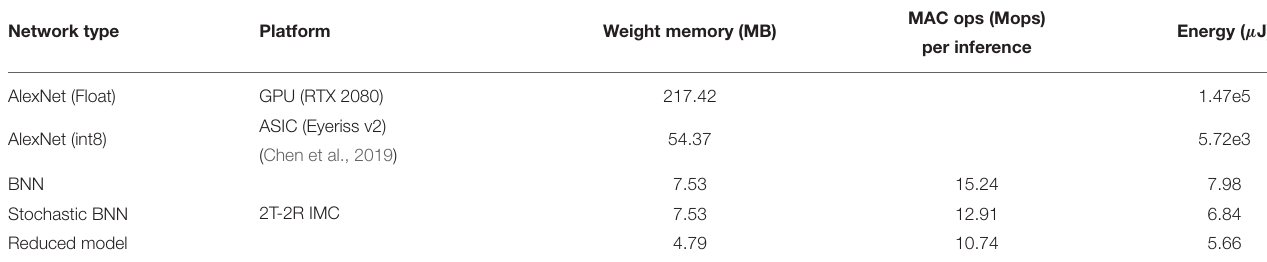
TABLE 3 | Performance estimates of inference with multiple architectures for microscopy image